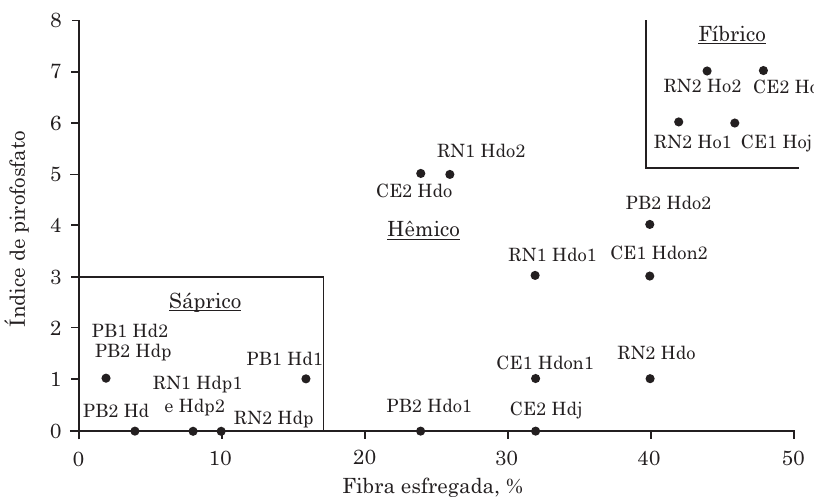
Figura 3. Grau de decomposição da matéria orgânica determinado em função da relação entre os valores de fibras esfregadas e o índice de pirofosfato. Sáprico: material orgânico em estádio avançado de decomposição; Hêmico: estádio intermediário; e Fíbrico: material orgânico pouco